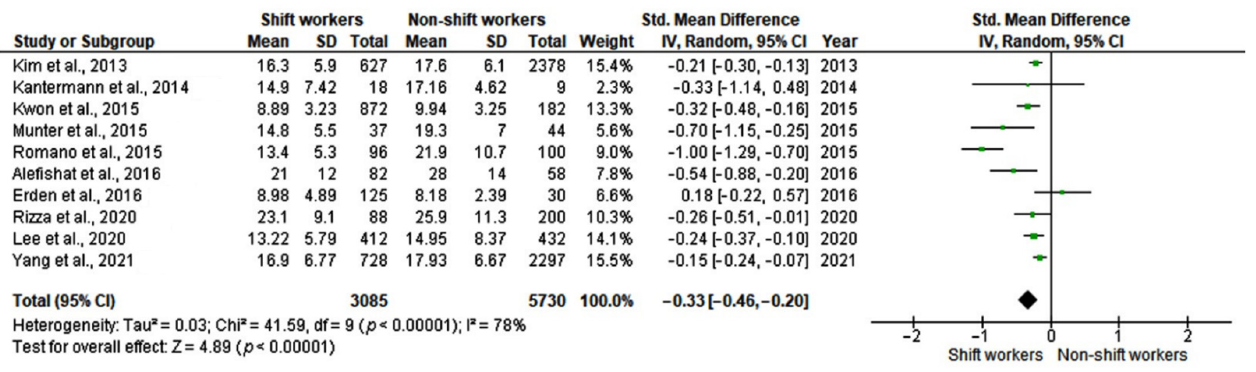
Figure 5. Forest plots showing mean differences in serum 25-hydroxyvitamin D (25-OH-D) levels (ng/mL) in shift workers and non-shift workers (omitting unspecified methods of vitamin D measurement) [12,24,25,27,29,31–35].